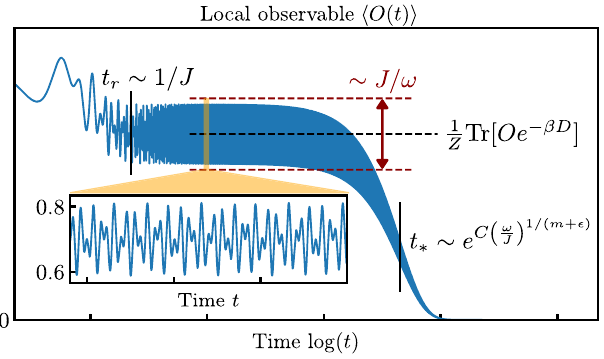
FIG. 2. Prethermalization in quasiperiodically driven systems at high frequencies. Shown is a cartoon of the dynamics of a generic traceless local observable h O ð t Þi under time evolution by Eq. (6). There are three regimes. First, a brief transient regime, where the ∼ 1 =J , where J is local observable relaxes on a short timescale t r the local energy scale of the system. Second, a prethermalization regime, where the system has locally equilibrated to a thermal ensemble of an effective static Hamiltonian D , when viewed in the rotating frame defined by P ð t Þ . The evolution h O ð t Þi in the laboratory frame shows a plateau around the prethermal value (black dashed line), with small time-quasiperiodic oscillations of amplitude of ∼ J= ω (red dashed lines); here, ω ¼ j ω j is the norm of driving frequencies. This regime lasts up to the long heating ∼ exp ½ C ð ω =J Þ 1 = ð m þ ϵ Þ (cid:3) . Third, a final featureless infinite- time t (cid:2) temperature state, reached after the system has fully heated. The inset shows a zoom-in on the orange-shaded region in the prethermal